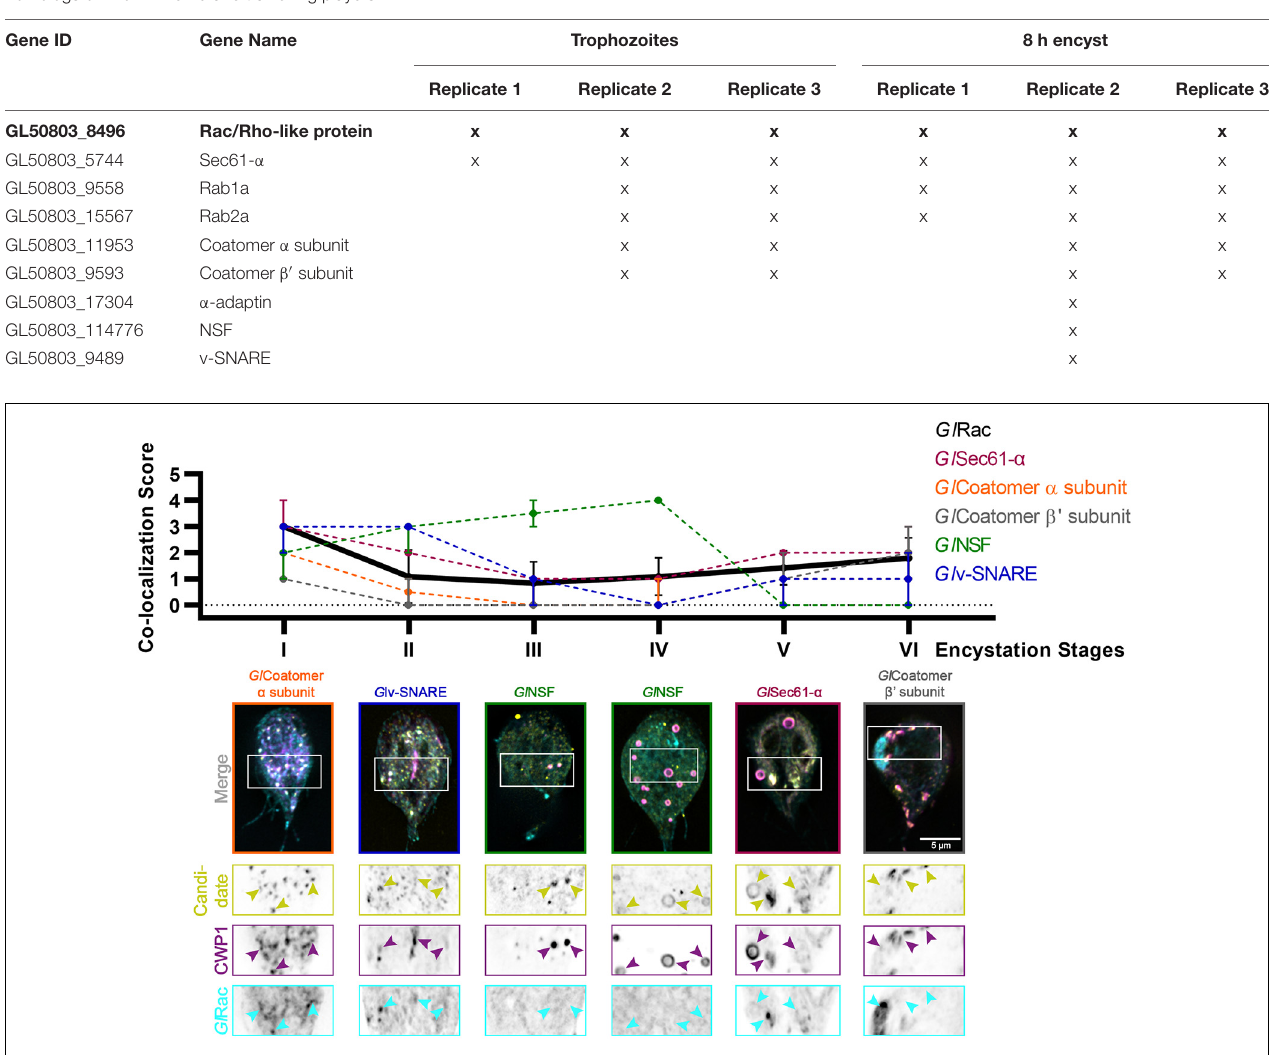
FIGURE 4 | Putative effectors of Gl Rac colocalize with CWP1 in a stage-specific manner in a pattern that is similar to Gl Rac. Summary of findings from colocalization analysis of putative Gl Rac interactors and CWP1 through all the encystation stages described above. Cells expressing endogenously tagged HALO- Gl Rac and mNG-HA tagged candidates were subjected to the two-step encystation process. They were then harvested at 8 and 24 h p.i.e. to be fixed and stained for CWP1. 15–20 cells per encystation stage were then imaged to visualize HALO- Gl Rac (cyan) or HA-mNG-candidate/candidate-HA-mNG (yellow) and CWP1 (magenta) and scored for the level of colocalization between the tagged candidate and CWP1 stained structures. Plot shows median scores with 95% confidence interval. Arrowheads indicate candidate proteins colocalizing with CWP1-stained ESVs.